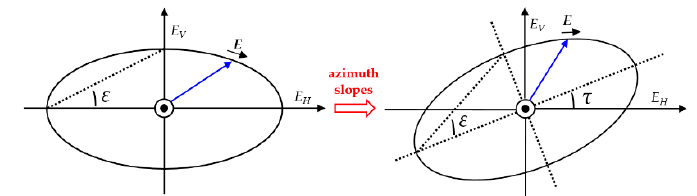
Figure 3. The rotation of the polarisation ellipse caused by the azimuth slope. E : actual electric field vector, E H : direction of horizontal component, E V : direction of vertical component, τ : polarisation orientation angle, ε : ellipticity angle.